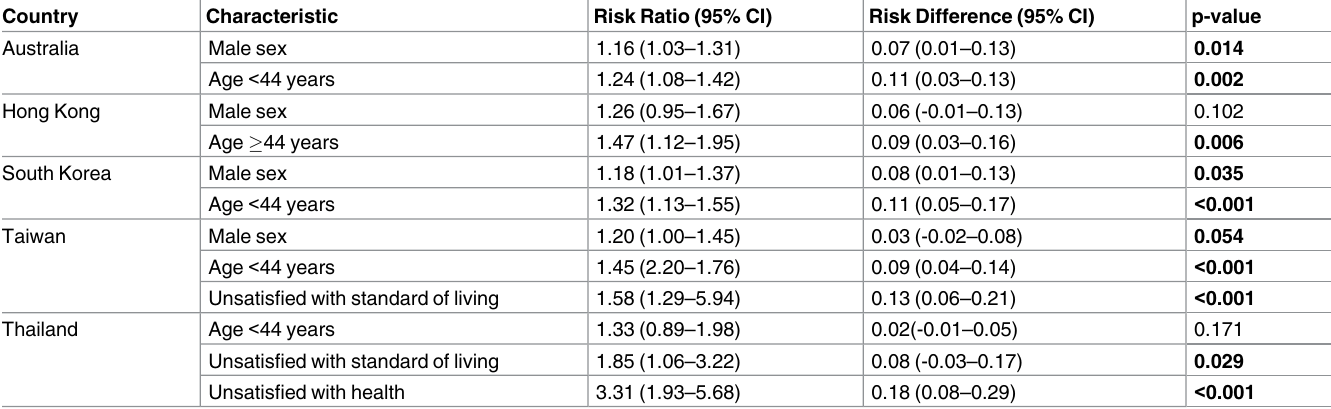
Table 7. Multivariate regression models for lower trust (trust ‘not at all’ or ‘not much’) in Banks in each country.